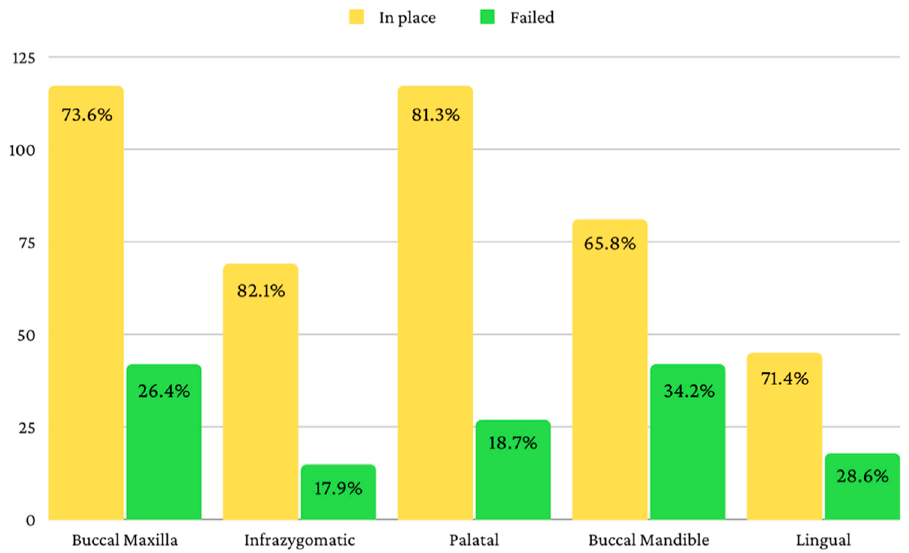
Figure 2. Mini-implants in place and rejected after more than three months.